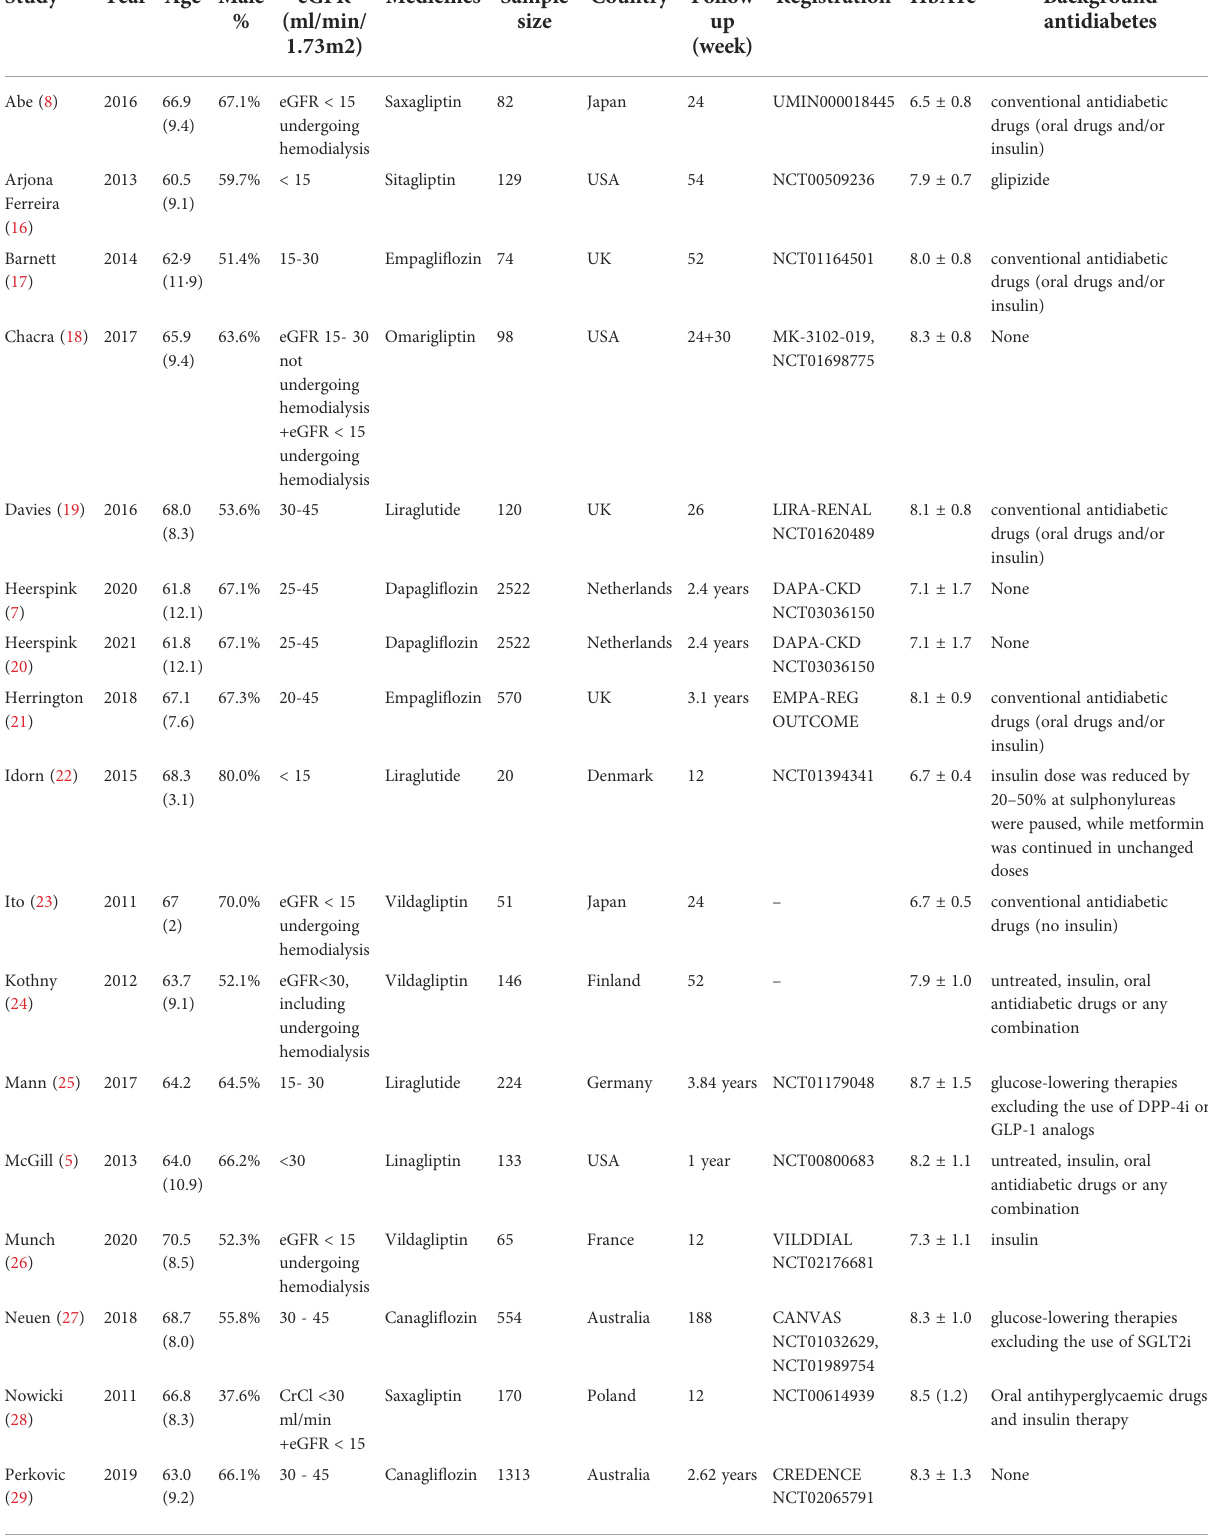
TABLE 1 Characteristics of included